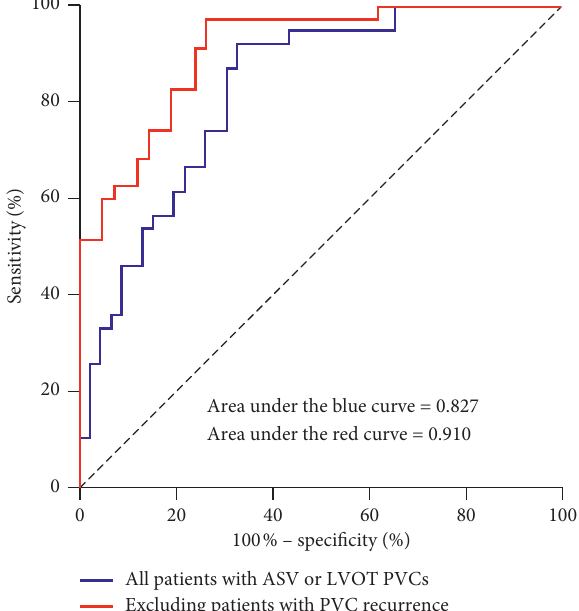
Figure 3: Differences in circadian patterns among PVCs of left fascicular origin. Circadian pattern distributions for PVCs arising from left fascicular systems and left papillary muscles. ∗ Indicates p < 0 . 05. LAF, left anterior fascicle; LAPM, left anterior papillary muscle; LBB, left bundle branch; LPF, left posterior fascicle; LPPM, left posterior papillary muscle.